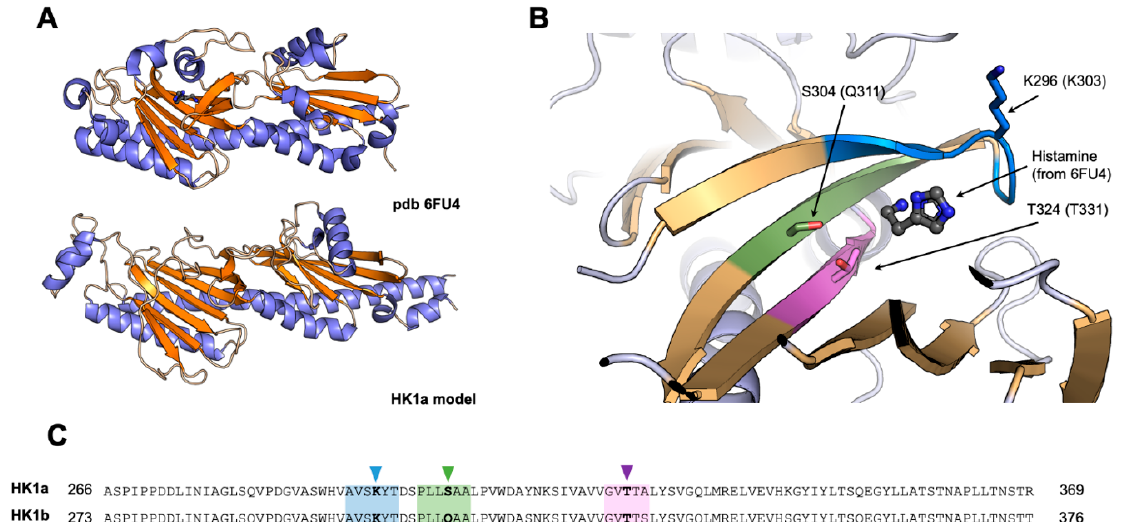
Figure 2. Selection of mutants involved in ligand binding in HK1a and HK1b. ( A ) Structural comparison between HK1a model and P. aeruginosa histamine receptor (PDB 6FU4). Helices and sheets are respectively coloured in blue and orange. ( B ) Close view of the putative binding site of HK1a, with the histamine bound from 6FU4, after the structural alignment of HK1a model and 6FU4 structure. The closest zones in contact with histamine are respectively coloured in blue, green and pink. The selected residues for mutagenesis are depicted in ball and sticks and labelled with the HK1a sequence numbering (HK1b). ( C ) Sequence alignment of HK1a and HK1b. The zones highlighted in panel ( B ) are identically coloured, and mutated residues are highlighted with arrows.